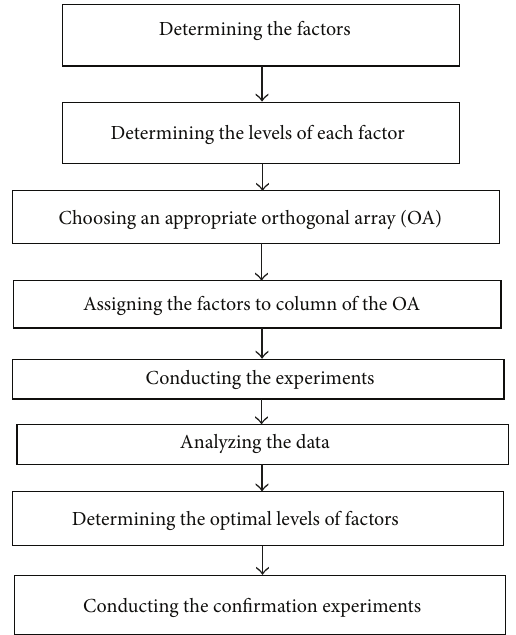
Figure 4: Application steps in the Taguchi method.